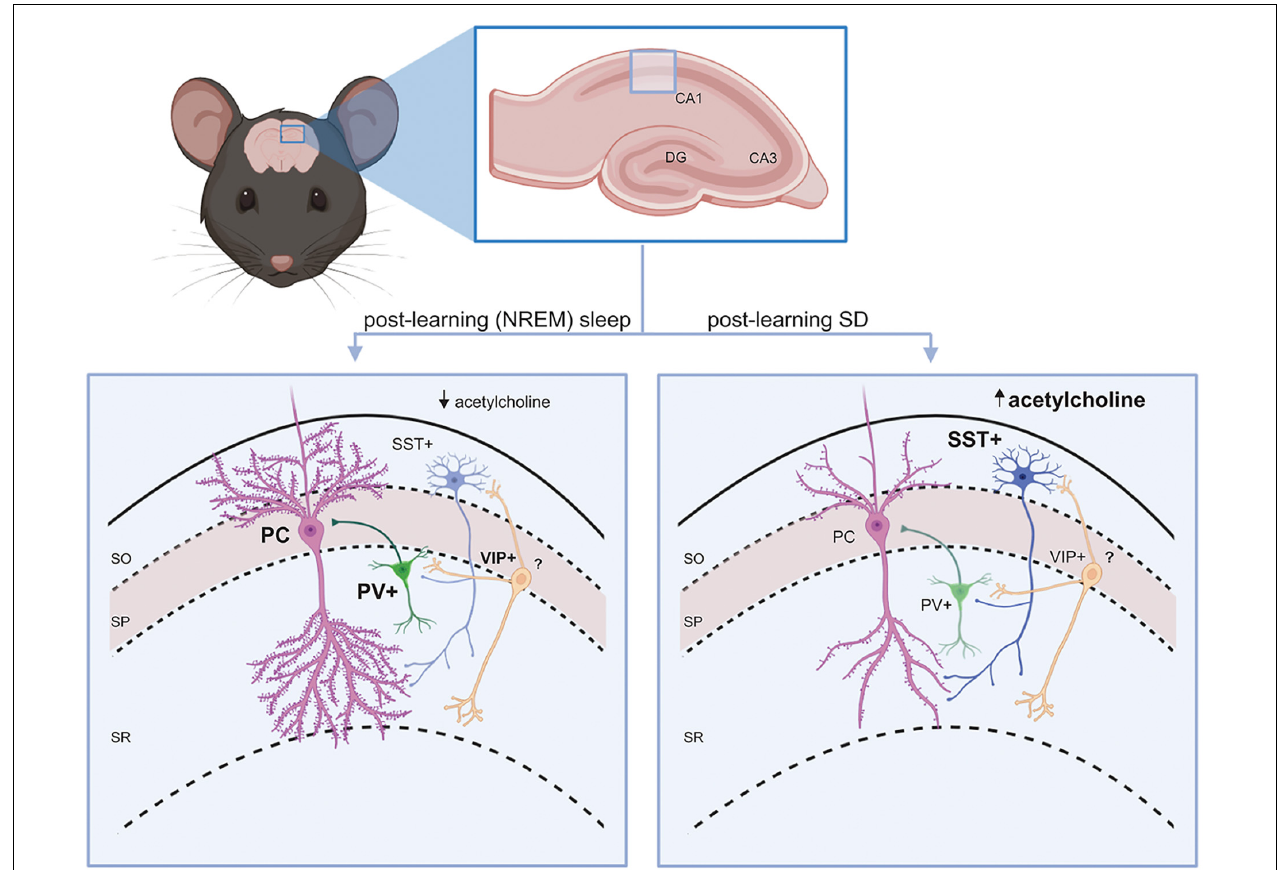
FIGURE 1 | Interneuron circuit motifs and their regulation by state. A conserved interneuron motif (present throughout hippocampus and neocortex) is shown in the mouse CA1. PV+ and SST+ interneurons provide inhibitory GABAergic input to principal (glutamatergic) cells’ (PCs’) soma/axon initial segment and dendrites, respectively. VIP+ interneurons inhibit SST+ interneurons in the circuit. Left: During a period of post-learning sleep, principal cells and PV+ interneurons generally become more active (Ognjanovski et al., 2014), while SST+ interneurons are relatively quiescent (due to lower acetylcholine-mediated activation in NREM sleep) (Delorme et al., 2021). Some principal neurons (engram neurons) will become selectively more active, and may form new and/or stronger synaptic connections (Clawson et al., 2021). PV+ interneurons promote more coherent NREM and REM sleep oscillations (Ognjanovski et al., 2017, 2018). All these features are essential components of sleep-dependent memory consolidation. Right: When learning is followed by SD, SST+ interneurons shown increased activity in response to higher acetylcholine levels (Delorme et al., 2021). VIP+ interneurons may also have reduced activation, reducing inhibitory input to SST+ interneurons. This leads to suppression of firing in surrounding principal neurons (Delorme et al., 2021). As a result, dendritic spines on engram neurons (and other principal neurons) will be reduced and connections between them will be weakened (Havekes et al., 2016; Raven et al., 2019; Havekes and Aton, 2020), which impairs memory